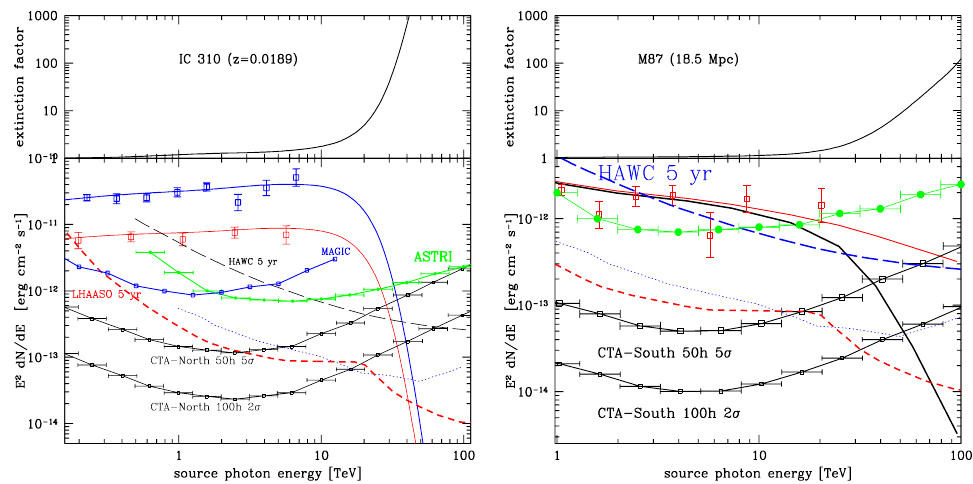
Figure 6. Left panel : Top : The photon–photon absorption correction ( exp [ τ γγ ] ) for the source IC 310 at z = 0.0189, based on the EBL model by [82]. Bottom : The blue data-points and continuous line were taken during an outburst phase, the red data and continuous line during a prolonged high-state. The 50-h 5 σ and 100 h 2 σ sensitivity limits for CTA, and the HAWC 5 years limits are shown. The blue dotted line and the red dashed one indicate the SWGO and LHAASO 5 year 5 σ limits, respectively. The 50-h limit for the forthcoming ASTRI mini-array is shown in green. Right panel : Photon–photon absorption for the source M 87 at 18.5 Mpc. The observed (open red and continuous line) and absorption-corrected (black line) spectral data are reported. Same as in the left panel. (Figure taken from